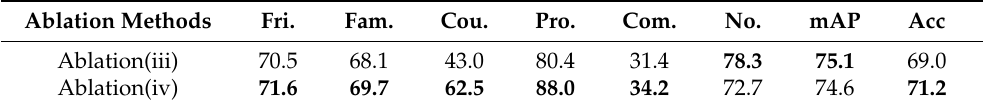
Table 5. Detailed comparison between ablation (iii) and ablation (iv) on PISC-F dataset. Ablation (iii) consists of FE-ViT, Intra-TRM and Inter-TRM, while ablation (iv) introduces the new loss function into the training process on basis of ablation (iii). Better results are given in bold. Ablation Methods Fri. Fam. Cou. Pro. Com. No. mAP Acc